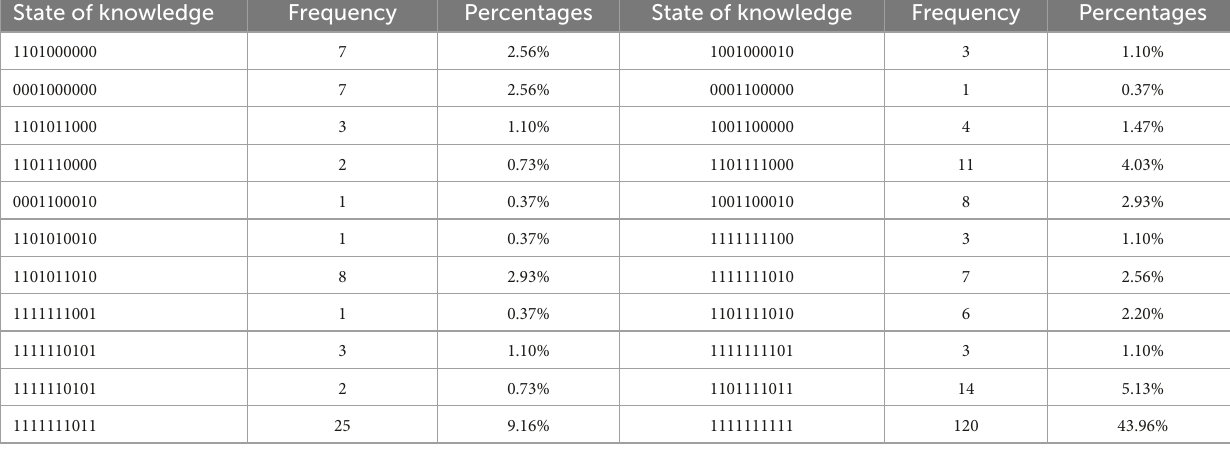
TABLE 6 Classification of subjects’ ideal mastery